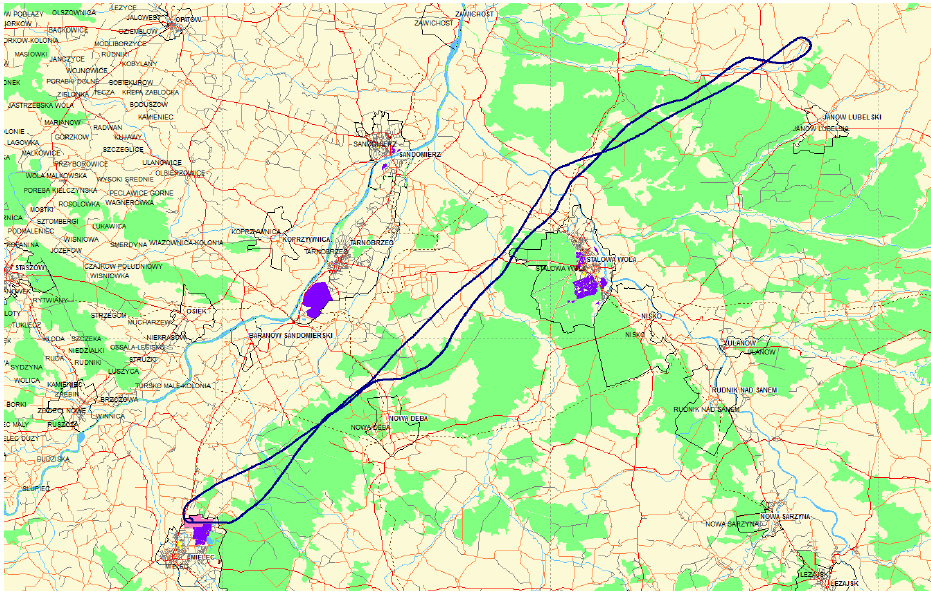
Figure 1. The aircraft trajectory in-flight experiment in Mielec airport [own material]. A Topcon HiperPro dual-frequency dual-system geodetic receiver was deployed on-board the Seneca Piper PA34-200T aircraft to record GPS/GLONASS code-phase observations on the L1/L2 frequency. The Topcon HiperPro receiver was located in the cockpit. The Topcon HiperPro receiver recorded GPS/GLONASS code-phase observations with an interval of 1 s. The flight test was performed in real time. The receiver was collecting real-time GPS/GLONASS data for the numerical analysis.